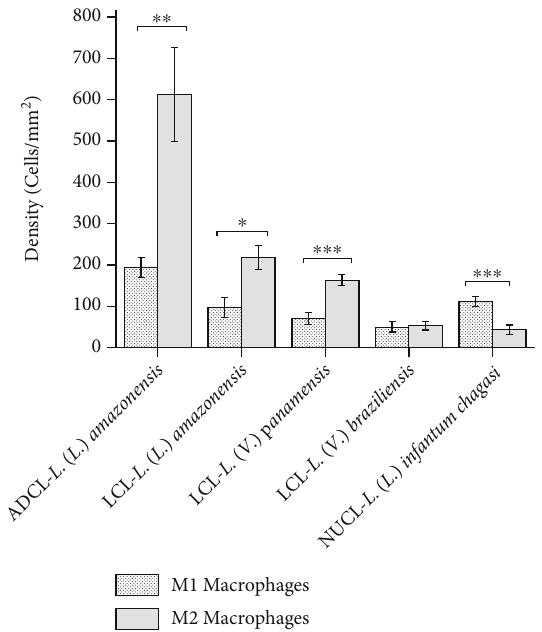
Figure 4: Percentage of M1 and M2 cells inside to total macrophages in the skin lesion of di ff erent clinical forms of American cutaneous leishmaniasis, anergic di ff use cutaneous leishmaniasis (ADCL) by L. ( L. ) amazonensis , localized cutaneous leishmaniasis (LCL) by L. ( L. ) amazonensis , L. ( V. ) panamensis , L. ( V. ) braziliensis , and nonulcerated cutaneous leishmaniasis (NUCL) by L. (L.) infantum